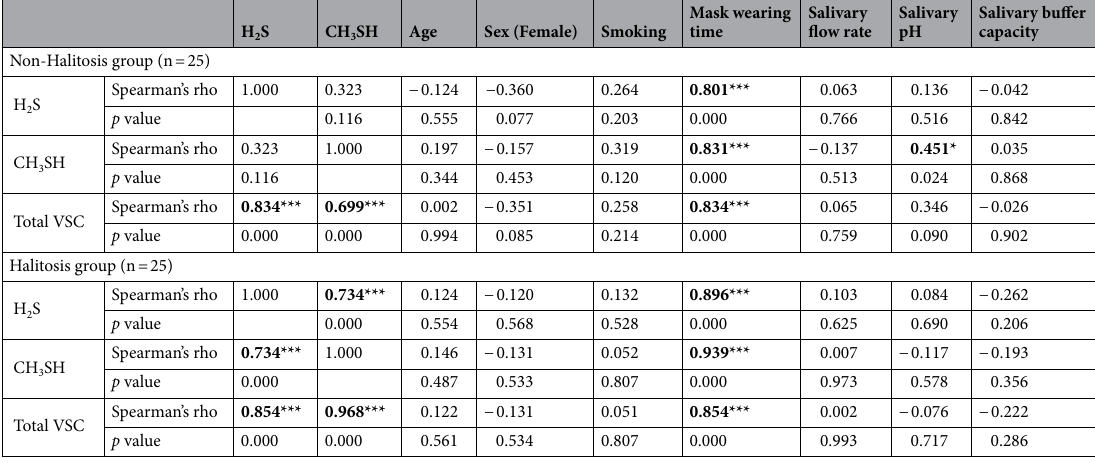
Table 3. Correlations between volatile sulfur compounds and clinical factors. Results were obtained using Spearman’s correlation analysis. Differences were considered significant at p < 0.05 (* p < 0.05, ** p < 0.01, *** p < 0.001). VSC: volatile sulfur compound level. Significant values are in